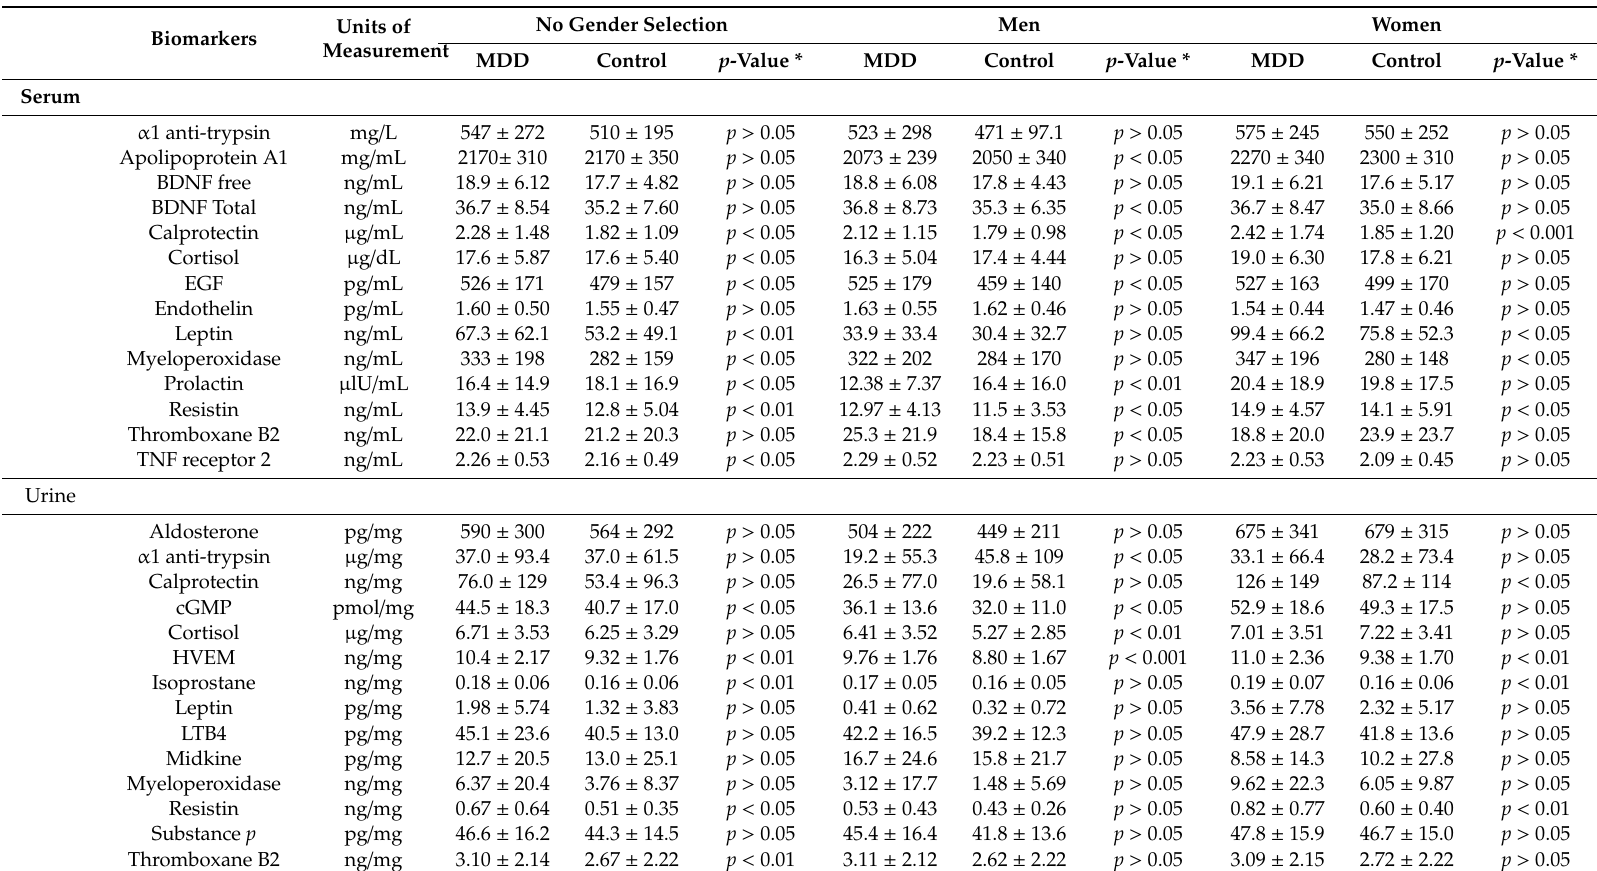
Table 3. Serum and urine biomarker concentrations with and without gender